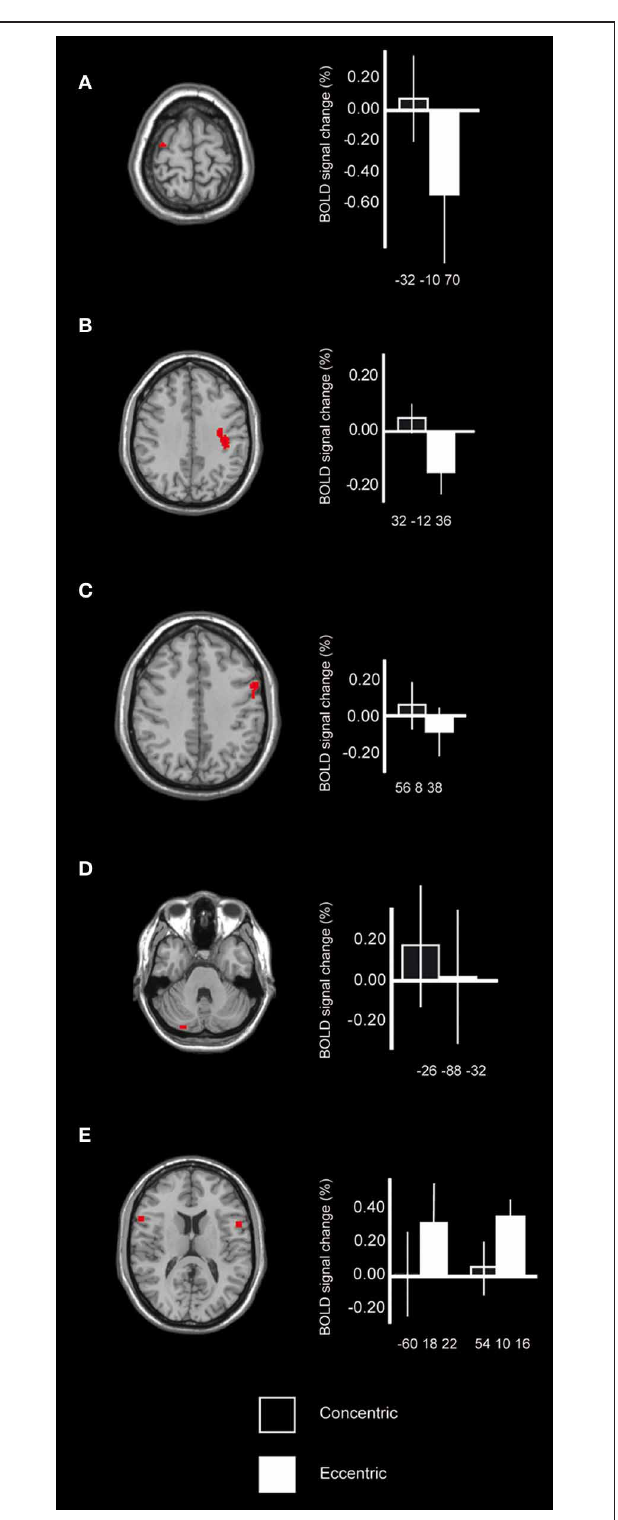
FIGURE 3 | Cortical activation differences while contrasting simulated maximum concentric and eccentric contractions. Motor cortex, BA 6/4 (A,B) as well as BA 6 (C) , showed increased signal change during the